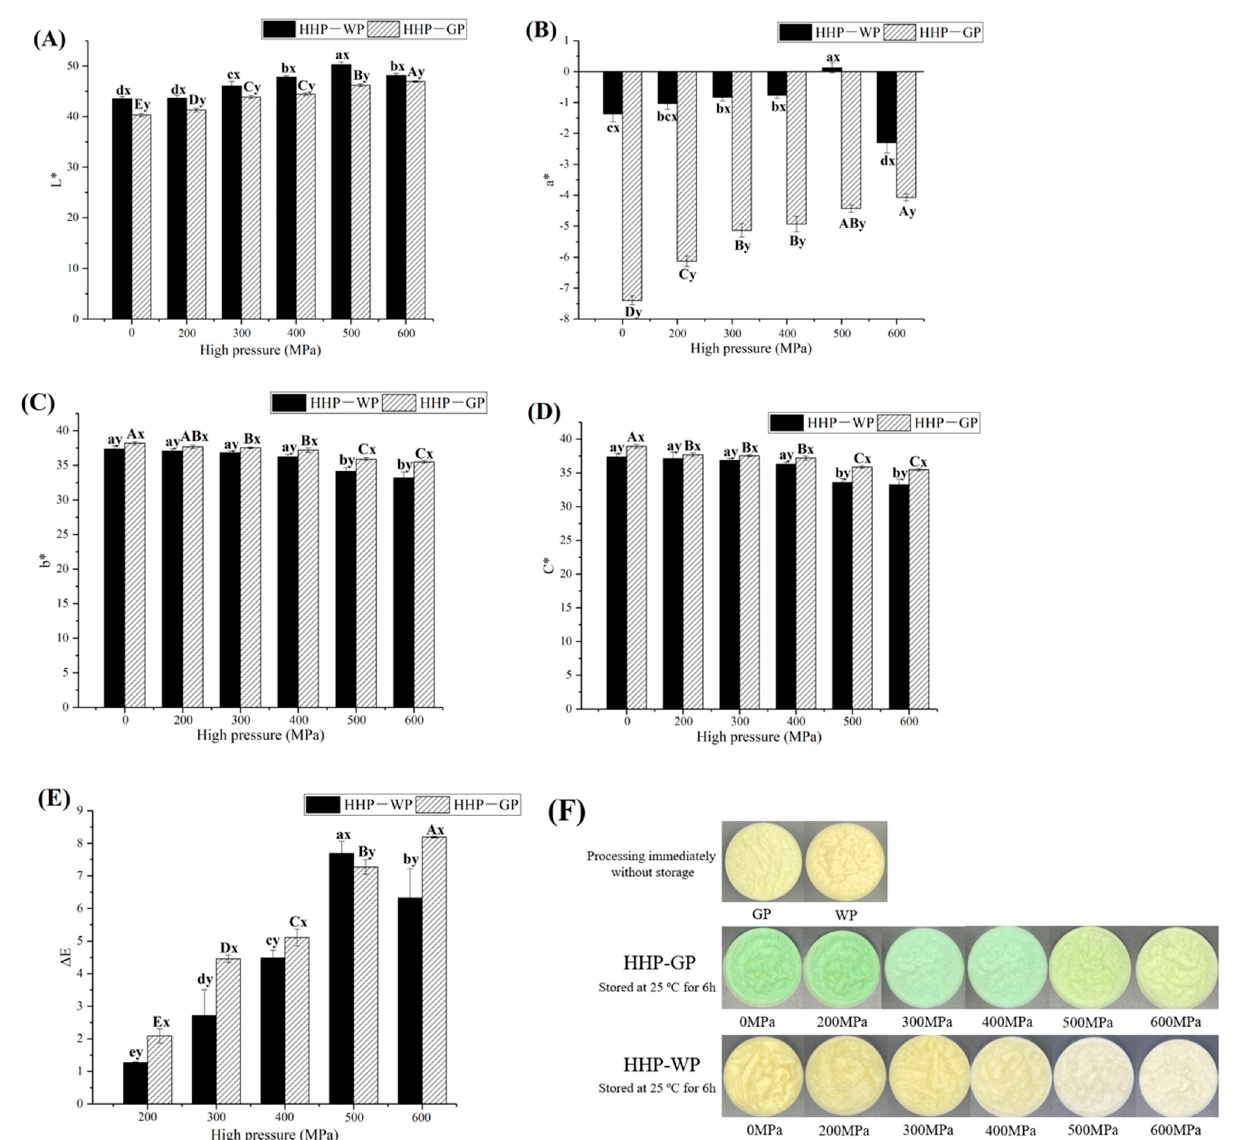
Figure 2. Effect of HHP treatment on garlic paste color indexes and appearances. ( A ) L*, ( B ) a*, ( C ) b*, ( D ) color chroma, C*, ( E ) total color difference, ∆ E, ( F ) color appearance. “a–e” and “A–E” mean within HHP-WP and HHP-GP group, respectively, while different letters indicate a significant difference ( p < 0.05). “x-y” with different letters indicates a significant difference ( p ≥ 0.05) between HHP-WP and HHP-GP under the same HHP conditions.